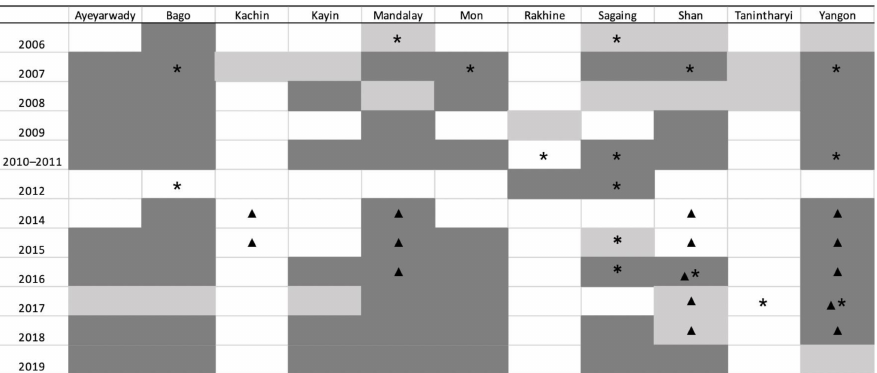
Figure 3. Study implementation from 2006 to 2019 by State/Region and year. Light shading: State/Region where serological surveillance was carried out, but no positives were found. Dark shading: State/Region where serological surveillance was carried out and positive farms were detected. Asterisk (*): State/Region where HPAI outbreak was reported in the OIE WAHIS. Triangle ( (cid:78) ): State/Region where HPAI was confirmed by PCR in active surveillance.